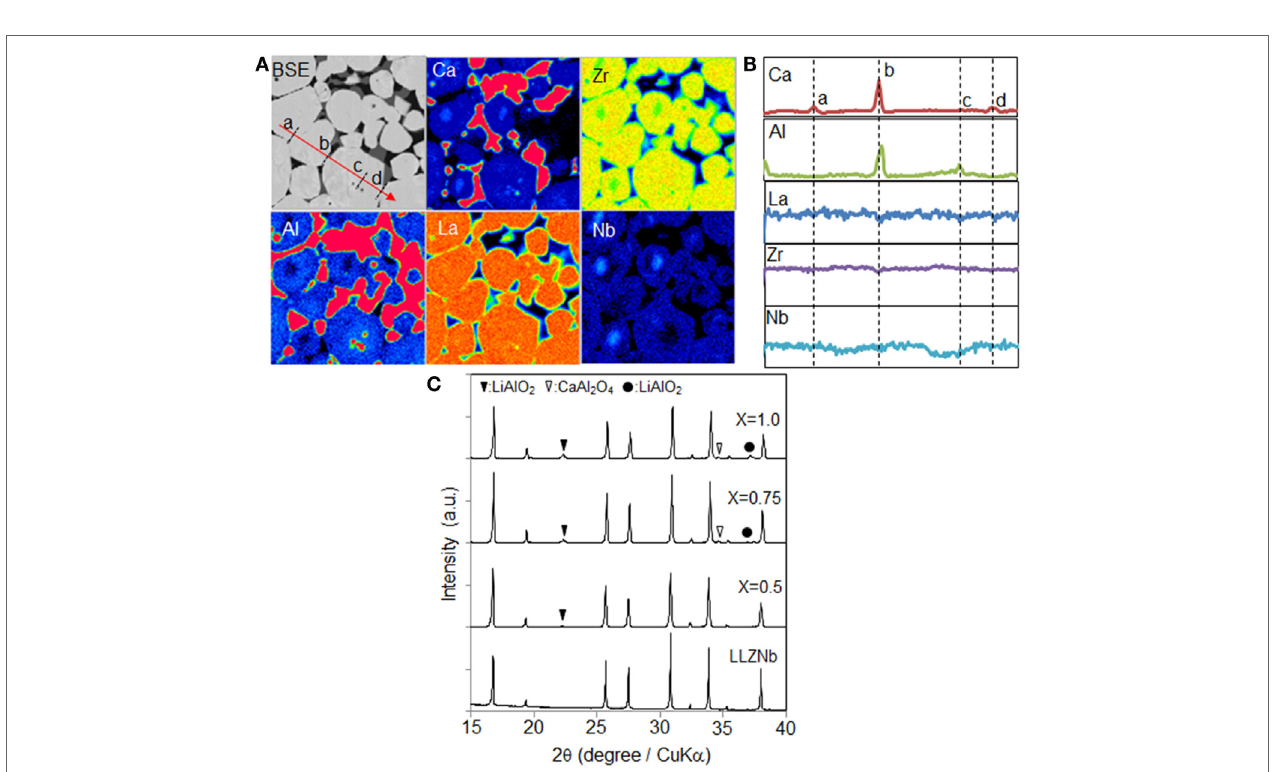
FigUre 2 | (a) Cross-sectional EPMA mapping images of Ca-LLZNb, (B) linear analysis of Ca, Al, La, Zr, and Nb, and (c) XRD pattern obtained from Ca-LLZNb.